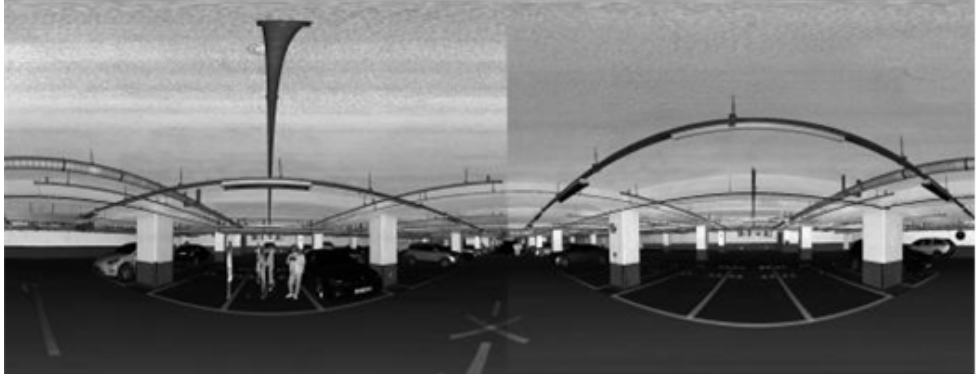
Figure 16. Acquired image from scanning.